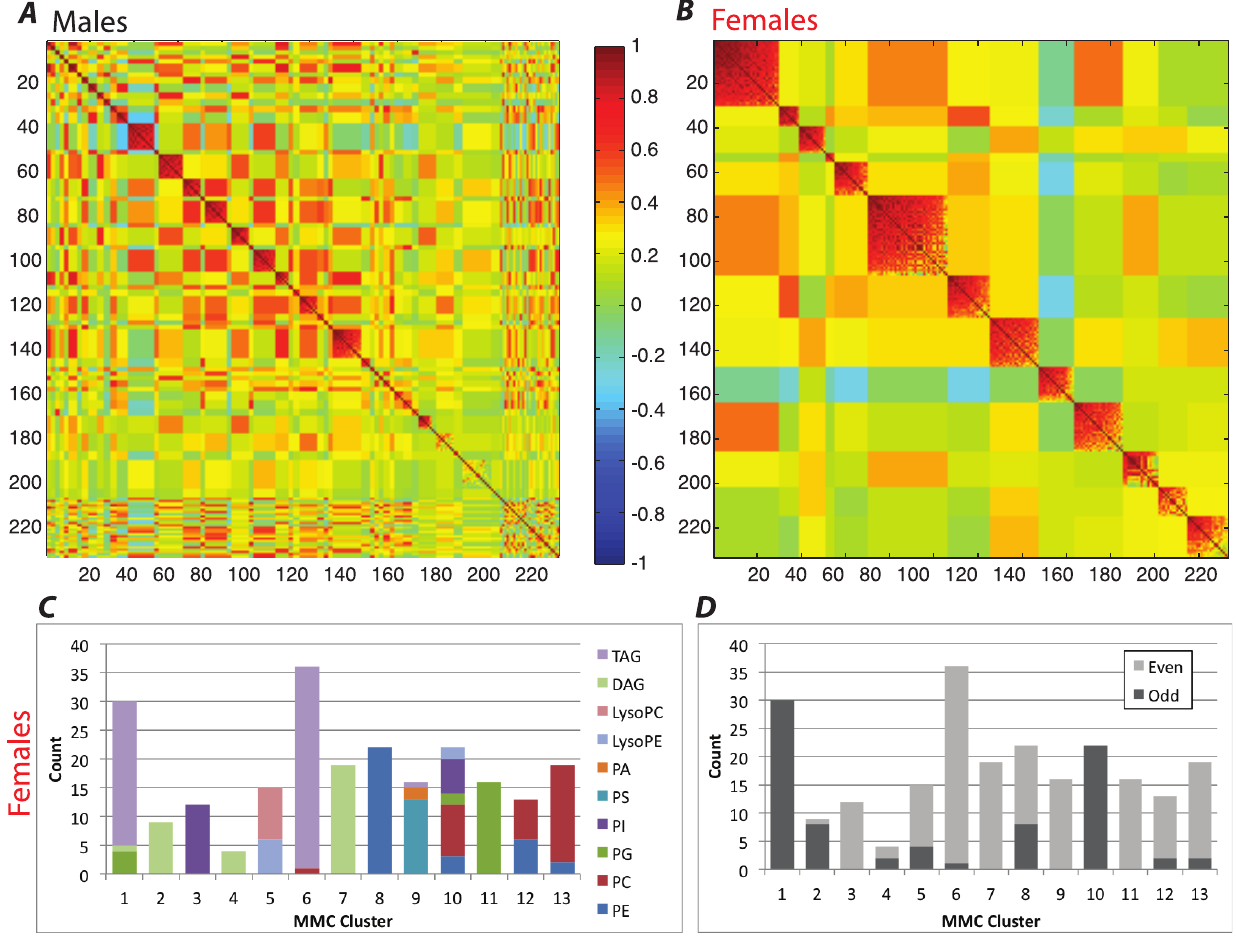
Figure 5. MMC clustering reveals distinct clusters only in female lipid data. A and B: MMC matrix for male (A) and female (B) lipid concentration with any population effect removed. C: Lipid class distribution across identified clusters in females (from B). D: Odd and even chain FA distribution across the same clusters.